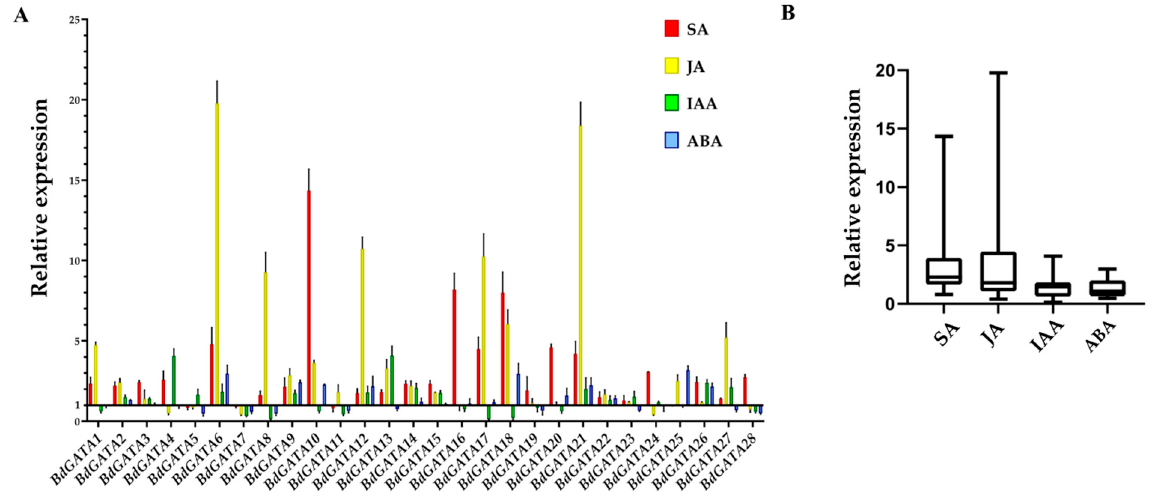
Figure 7. Expression profiles of BdGATA genes with phytohormone treatments. ( A ) Fold change in expression of BdGATA genes after hormone treatments. Fold change in BdGATA gene expression after hormone treatments assessed by qRT-PCR of cDNA isolated from hormone treatment plants were compared with mock treatment plants. Fold change of 1 means no difference in gene expression between hormone treatment plants and mock treatment plants. This assay was repeated three times with similar results. ( B ) Box–whisker plot of BdGATA gene expression after phytohormone treatments. The y -axis represents relative gene expression level. Whiskers represent maximum/minimum values, boxes indicate the first quartile and third quartile, and the horizontal line represents the median.